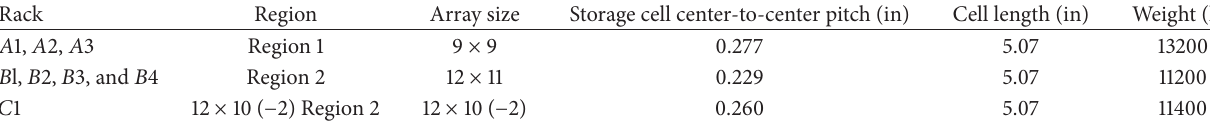
Table 1: AP1000 spent fuel storage racks data.